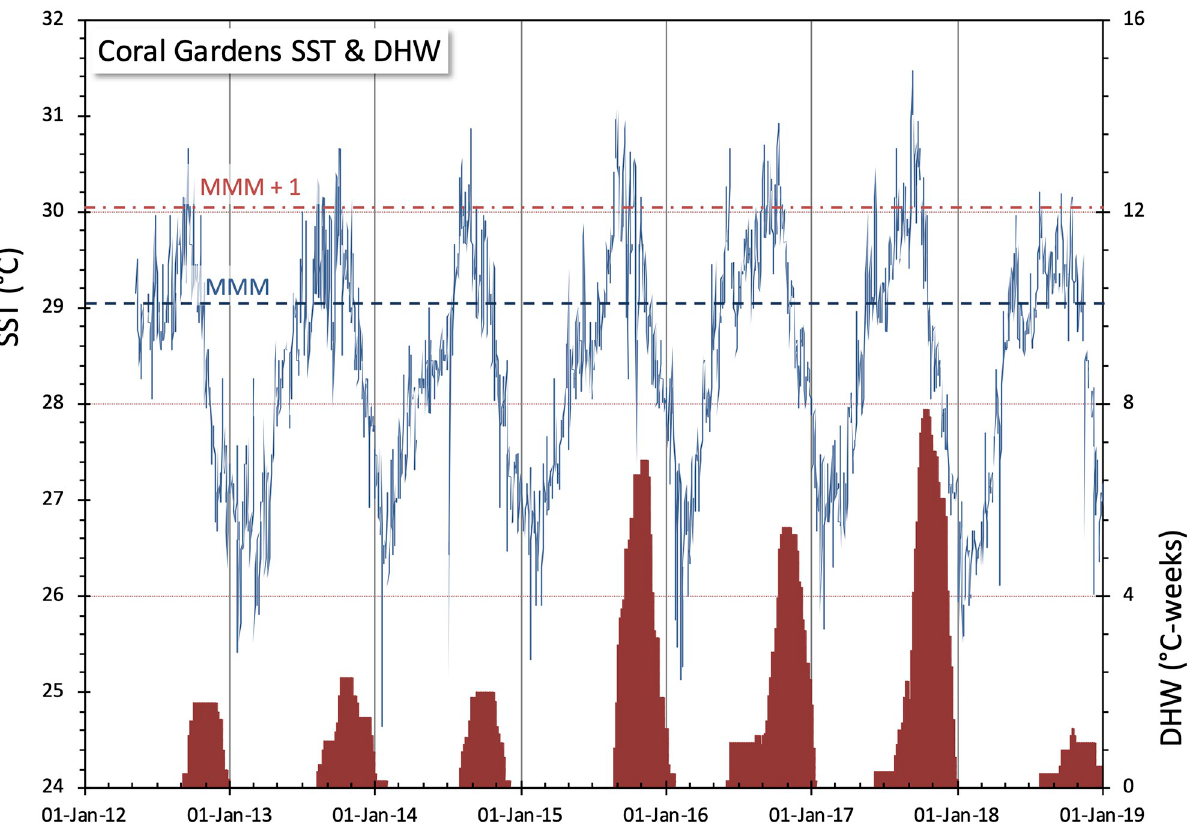
Fig 4. Mean daily SST and accumulated degree heating week at Coral Gardens from 2012–2019. Sea surface temperatures (thin blue line) are from in-situ sensors. Degree Heating Weeks (shown in red) accumulate when SST’s exceed the MMM + 1˚C threshold. See text for details.